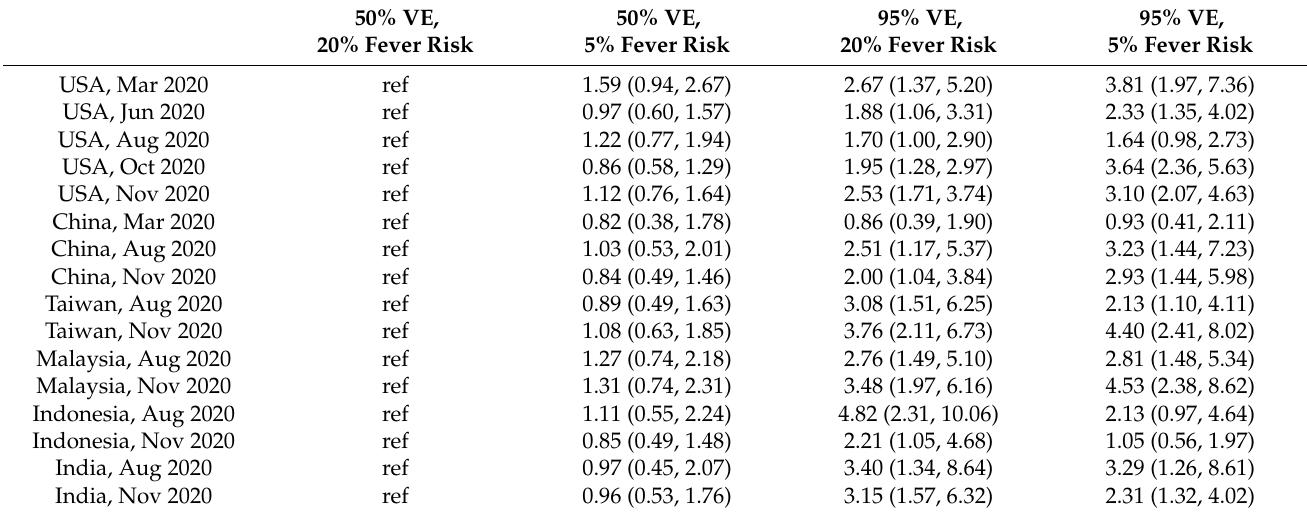
Table 2. Effect of vaccine effectiveness (VE) and risk of fever on acceptance of a COVID-19 vaccine using logistic regression models that output odds ratios and 95% confidence intervals, in six countries, August–November, 2020. 50%